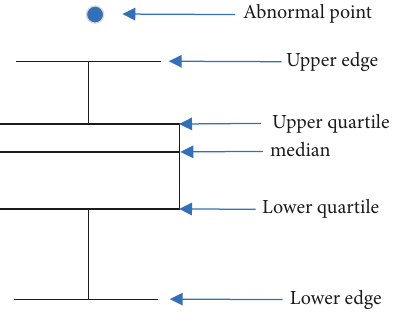
Figure 6: Schematic diagram of the box-and-line diagram